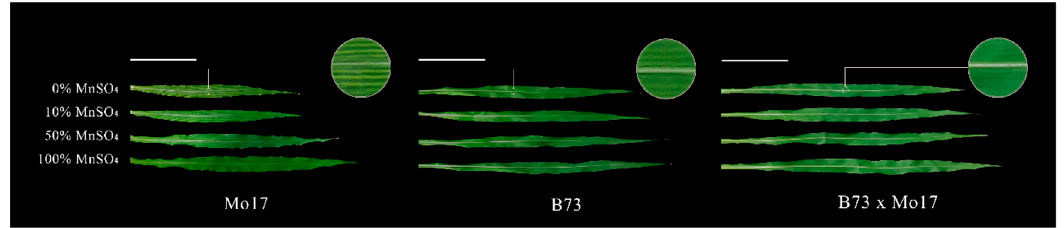
Figure 1. Effect of Mn deficiency on the leaves of maize seedlings, scale bar = 10 cm. Table 1. Analysis of variance of Mn deficiency on dry weight and plant height of maize seedlings of different genotypes.